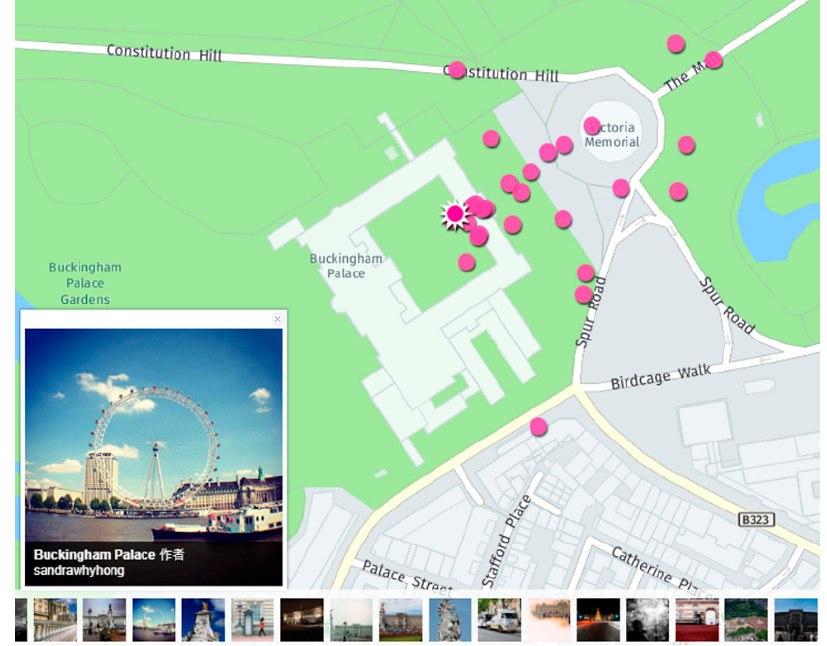
Figure 1. Unmatched-title image.